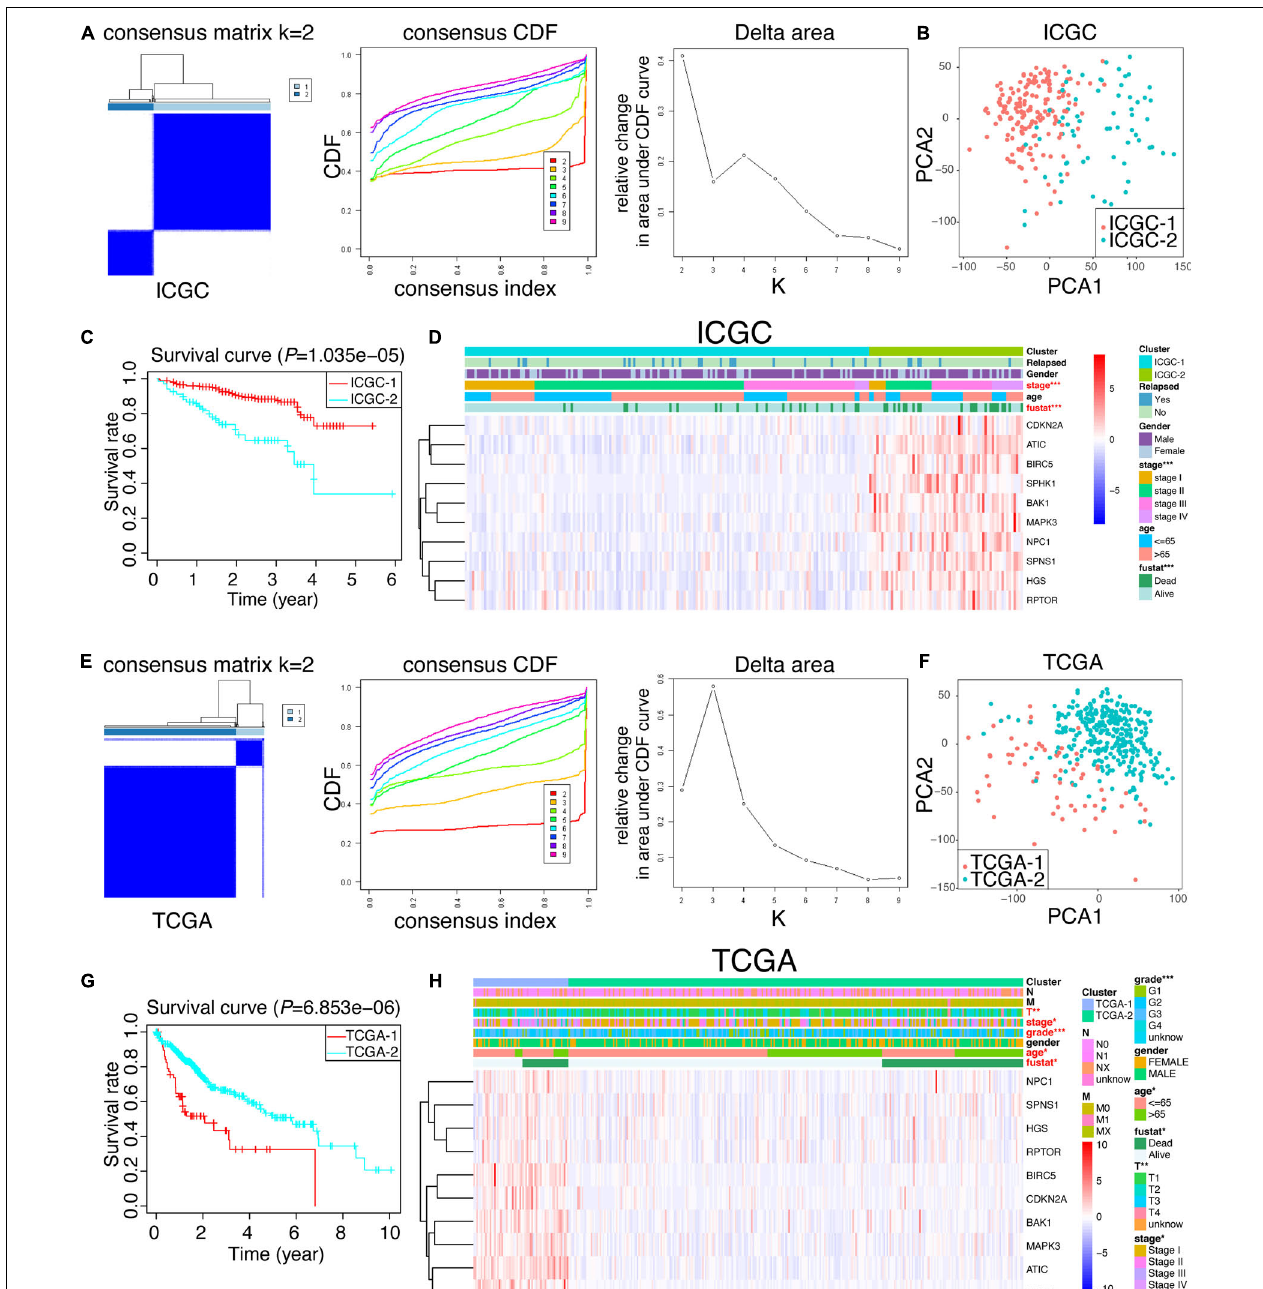
FIGURE 6 | Consensus cluster analysis and PCA analysis. (A,E) Cumulative distribution function (CDF) and relative change in the area under the CDF curve of the consensus cluster for k = 2–10 in ICGC and TCGA; k = 2 was presented and selected for further analysis. (B,F) PCA analysis of the RNA-seq profile of HCC patients in ICGC and TCGA. (C,G) Kaplan–Meier survival curves for HCC patients in ICGC and TCGA. (D,H) Heat map and clinicopathologic traits of the two clusters (cluster 1 and cluster 2) defined by the 10-hub-gene consensus expressions of ICGC and TCGA,